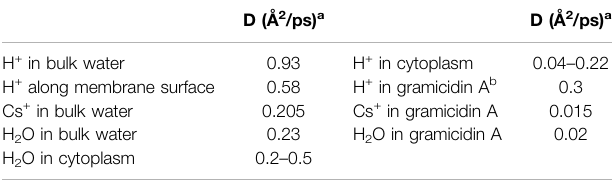
TABLE 3 | Diffusion coef fi cients (D) for cations and water, measured at 25 ° C (Wraight,